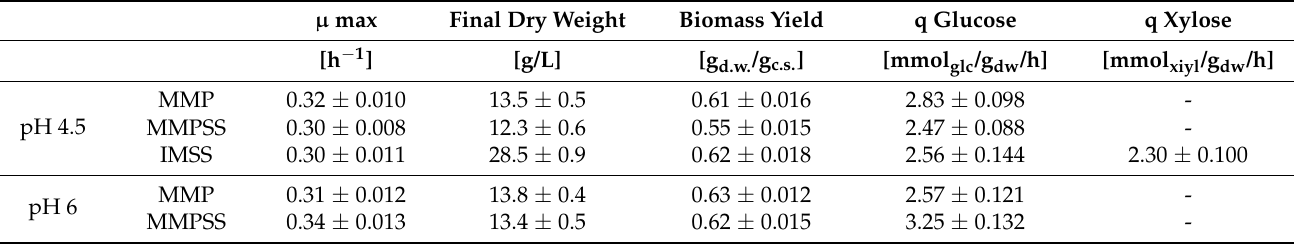
Figure 1. Growth of D. hansenii Mo40 strain in mineral media at different pHs without and with sea salts (SS). Blue: MMP pH 4.5, orange: MMPSS pH 4.5, grey: MMP pH 6, yellow: MMPSS pH 6. Table 1. Growth parameters of D. hansenii Mo40 cultivated in the absence (MMP) or presence of sea salts (MMPSS) and in an industrial-like seawater-based medium